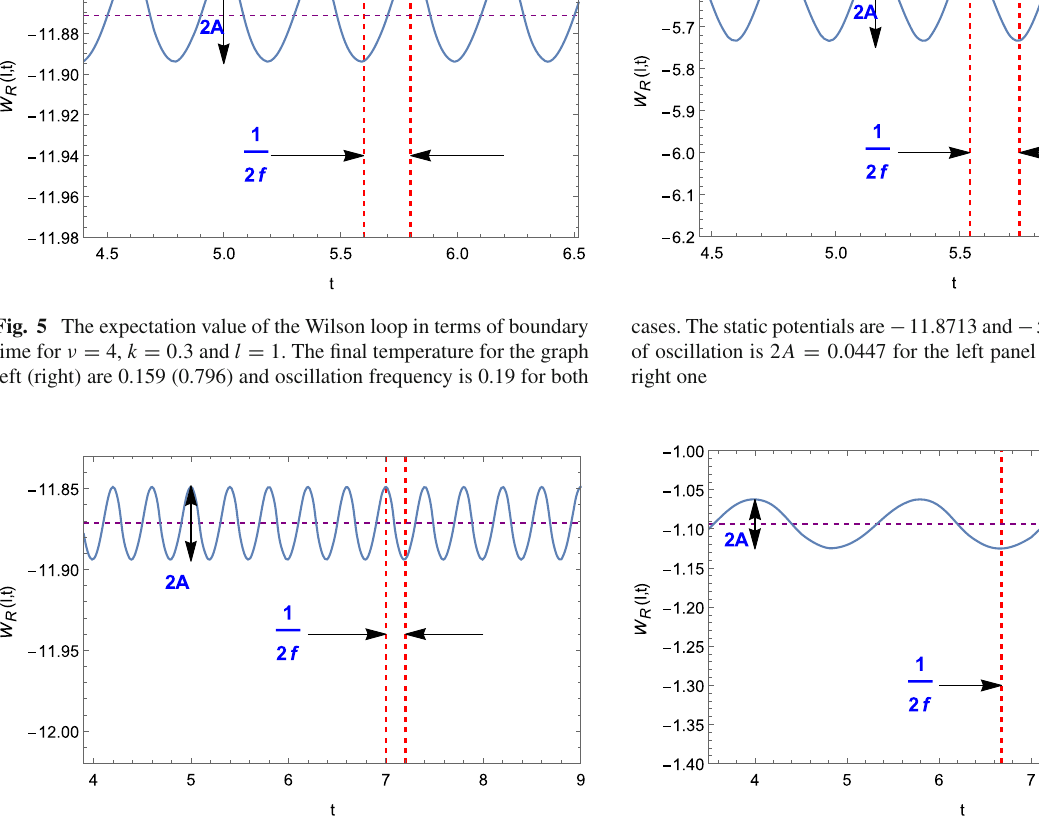
figure. The static potentials are − 11.8713 and − 1.0937. The amplitude of oscillation is 2 A = 0 . 0447 (0.0631) for the left (right)